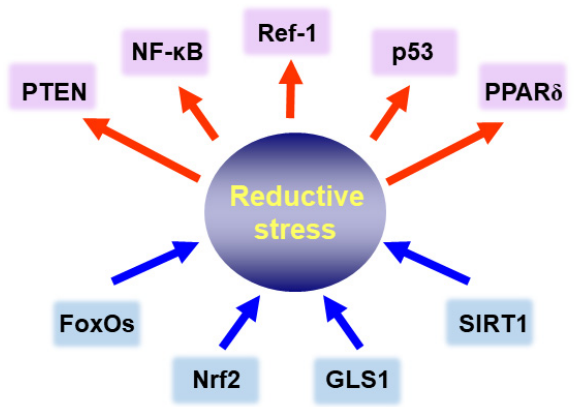
Figure 6. Intracellular signaling molecules modulating reductive stress in cancer cells. Blue arrows are signaling proteins that can induce reductive stress, and red arrows represent redox-sensitive proteins involved in cell growth and survival.